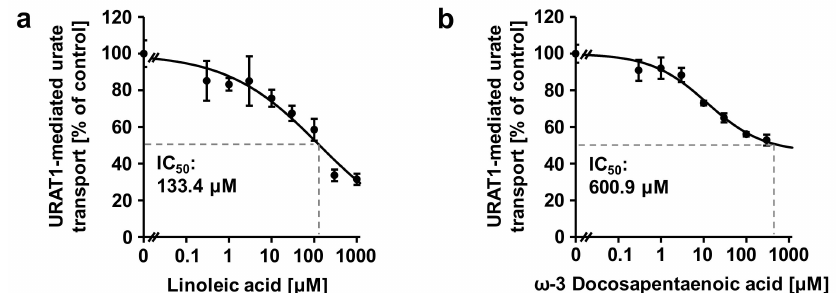
Figure A3. Concentration-dependent inhibition of URAT1-mediated urate transport by each fatty acid. Data are expressed as the mean ± SD; n = 4. ( a ) Linoleic acid; ( b ) ω -3 docosapentaenoic acid.